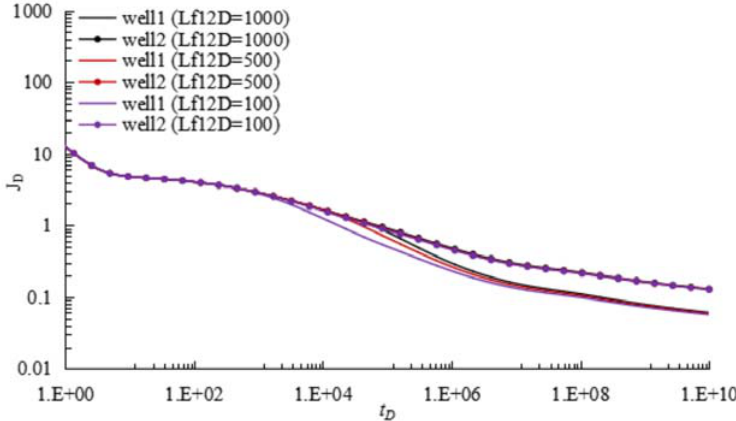
Figure 11. Effects of fracture spacing on MPI for WIPS scheme.